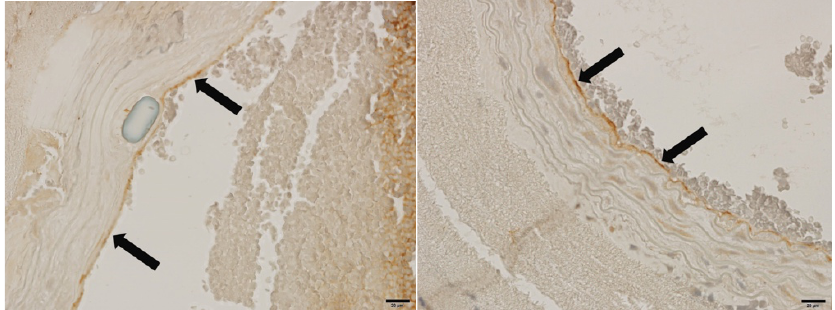
Figure 9. The 4-HR silk group vWF expression immunohistochemical results (Original magnification ×500, scale bar = 20 μm). The black arrows indicate vWF-positive areas.